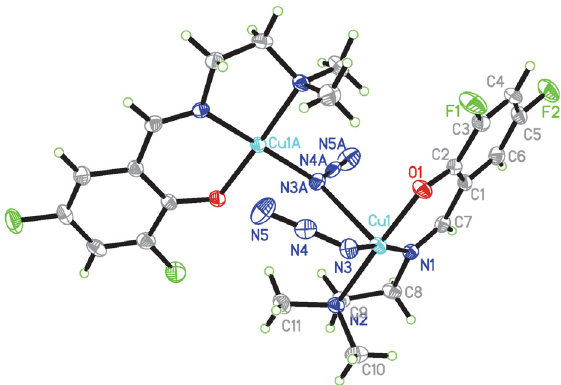
Figure 1 . A perspective view of complex 1 with the atom labeling scheme. Thermal ellipsoids are drawn at the 30% probability level.